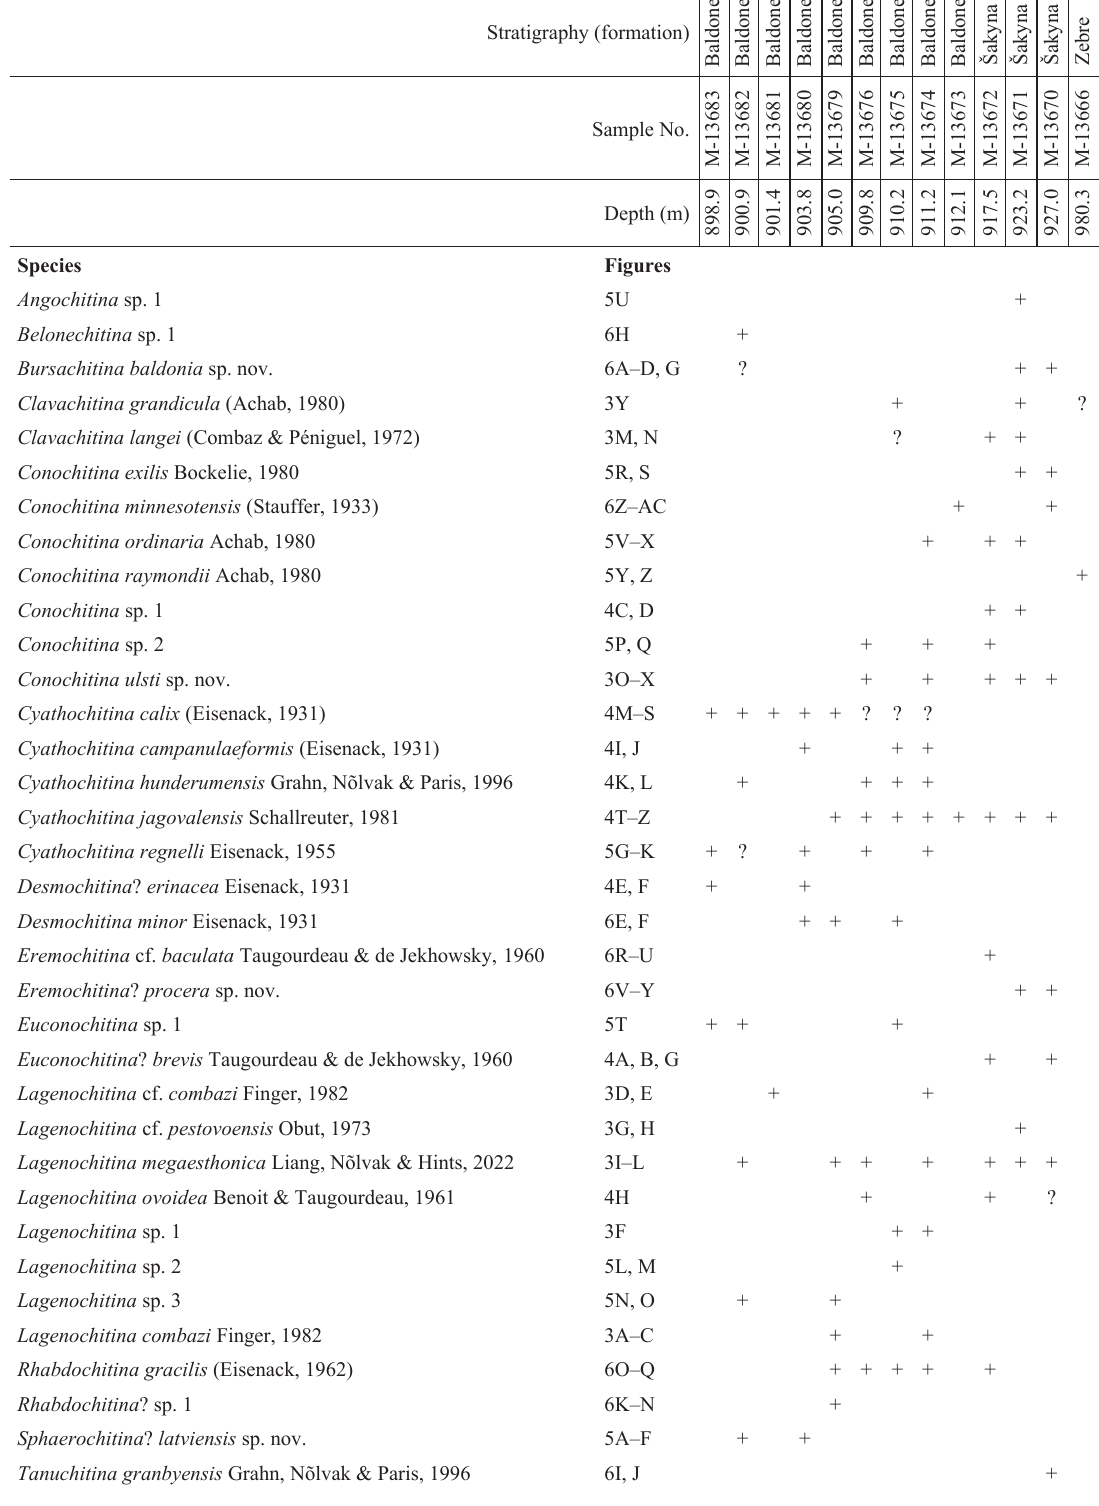
Table 1. List of chitinozoan species from the Lower and lower Middle Ordovician of the Baldone drill core, central Latvia. Occurrences are coded by ‘?’ in case of uncertain